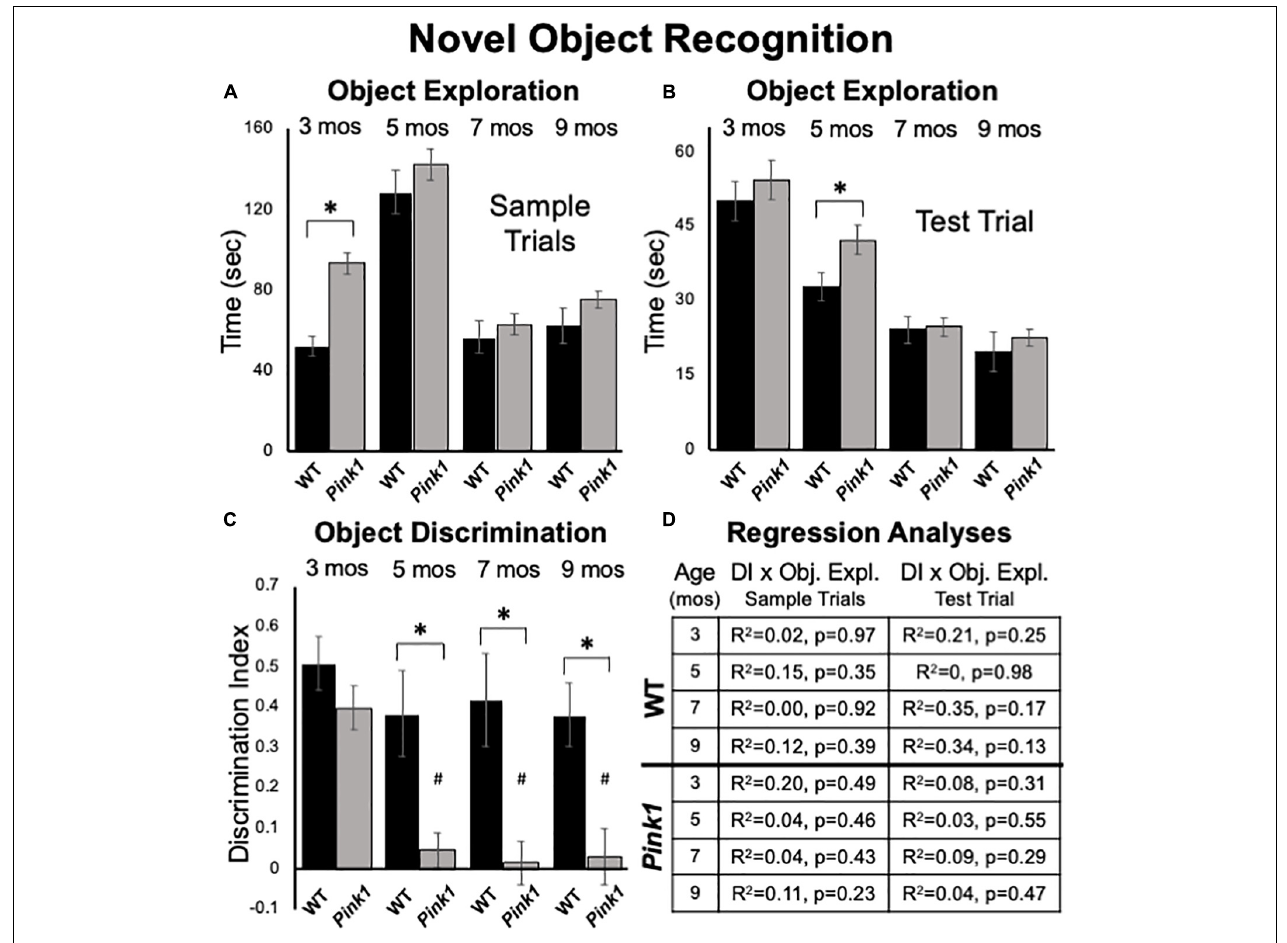
FIGURE 5 | Novel Object Recognition data. Bar graphs showing total times in seconds (sec) that wild type (WT, black bars) and rats with knockout of the PTEN (phosphatase and tensin homolog)-induced putative kinase1 gene ( Pink1–/–, gray bars) spent actively exploring objects during Sample Trials (A) and during Test Trials (B) in testing at 3, 5, 7, and 9 months (mos) of age. Overall, Pink1 –/– rats spent more time than WT rats investigating objects; asterisks identify these differences as significant at 3 mos of age for Sample Trials (A) , and for 5 mos of age for Test Trials (B) . (C) Bar graphs showing calculated discrimination index (DI) for WT (black bars) and Pink1 –/– rats (gray bars). This measure of object recognition memory was similar in rats of both genotypes at 3 months of age. At all other ages, DIs were significantly greater ( ∗ ) in WT than in Pink1 –/– rats. Within-groups comparisons of DI across age showed that in Pink1 –/– rats, DIs measured at 5, 7, and 9 months of age were significantly lower (#) than DI measured at 3 months of age. (D) Tables showing R 2 and p -values for regression analyses that compared DIs to total sample object exploration times and to test trial object exploration times in WT and Pink1 –/– rats at each age tested. No significant or near significant correlations were found among these